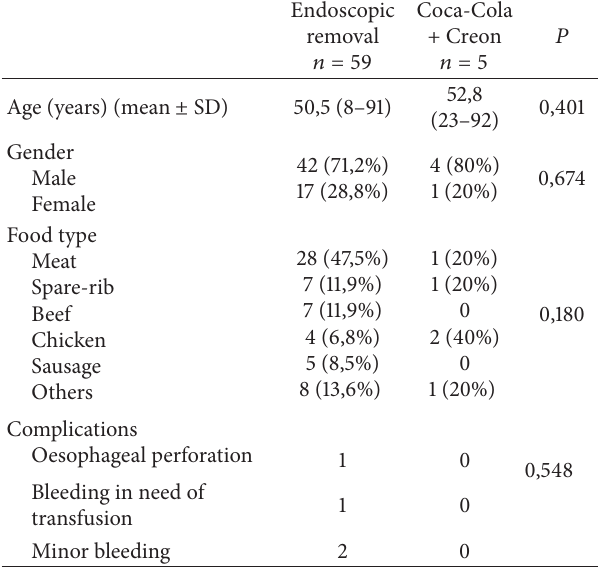
Table 3: 64 patients treated for impacted food in the